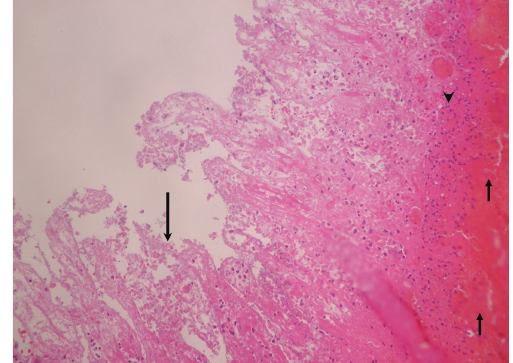
Figure 2: Histopathology signs of ischemic intestine of the resected small bowel show diffuse denuded mucosal surface (long arrow) with hemorrhagic infarction changes (short arrows), and superficial neutrophilic inflammation and fibrin deposition are seen within the lamina propria (arrow head). Hematoxylin-eosin stain, ×